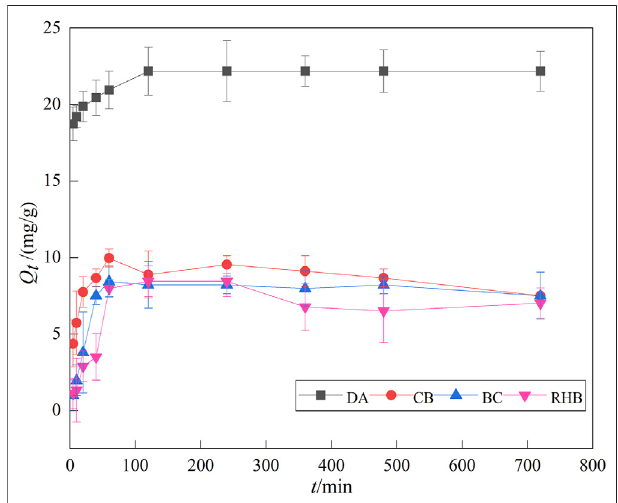
FIGURE 5 | Effect of adsorption time on F -